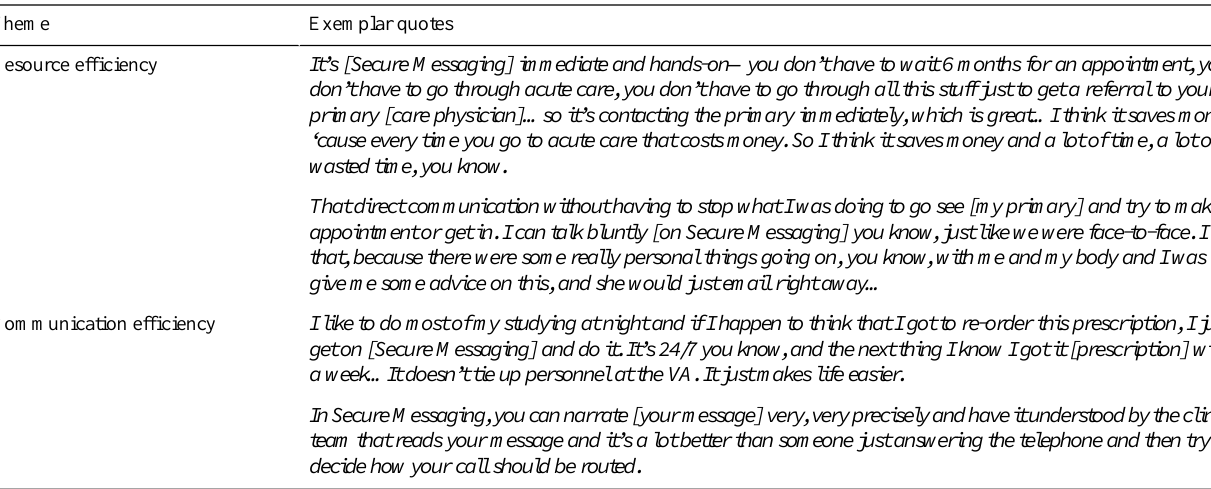
Table 3. Exemplar quotes of perceived benefits of using Secure